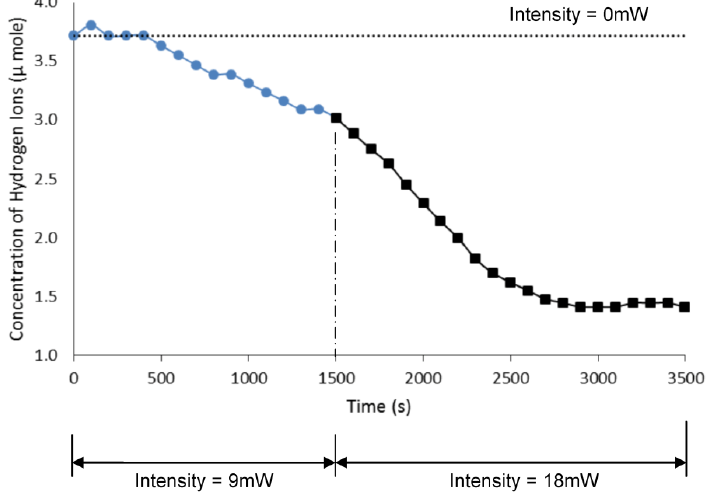
Figure 8. The change in H + ion concentration of the solution in reservoir R1 as a function of exposure to different levels of light intensity (0 mW, 9 mW, 18